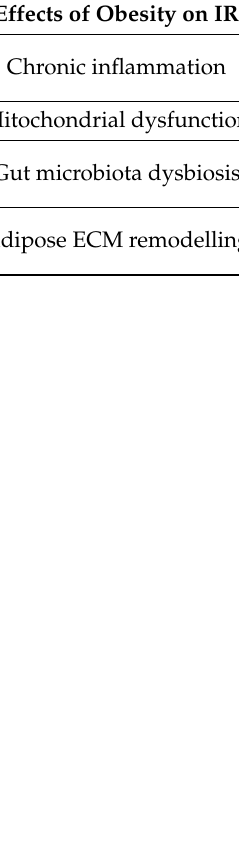
Table 1. IR at the crossroad of obesity with associated metabolic abnormalities and cognitive dysfunction: factors that mediate effects of obesity on IR, the metabolic and cognitive sequelae of IR and the lifestyle reversibility of IR. Factors that Mediate the Effects of Obesity on